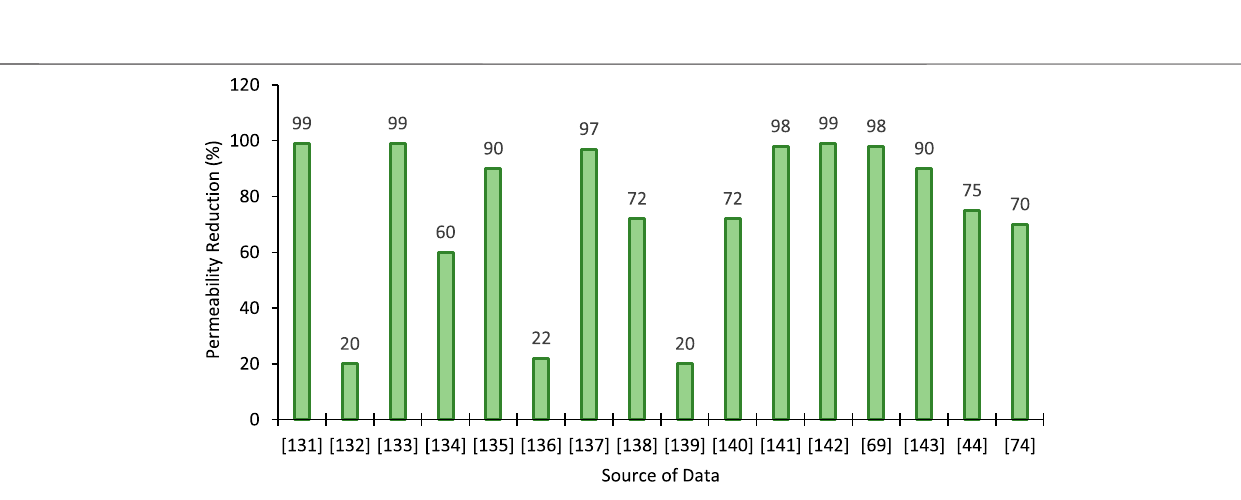
Frontiers in Bioengineering and Biotechnology |